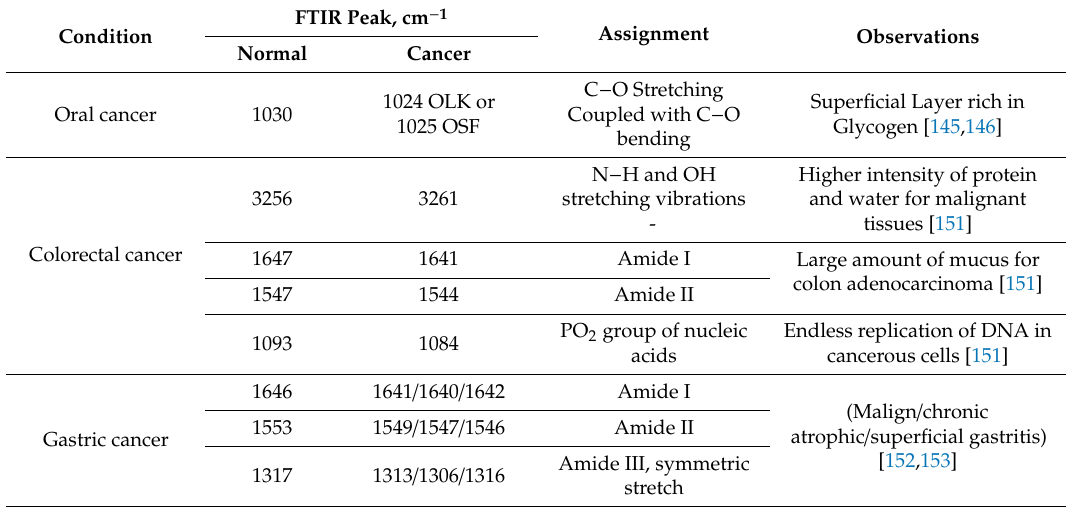
Table 6. The major bands assignments provided in GI